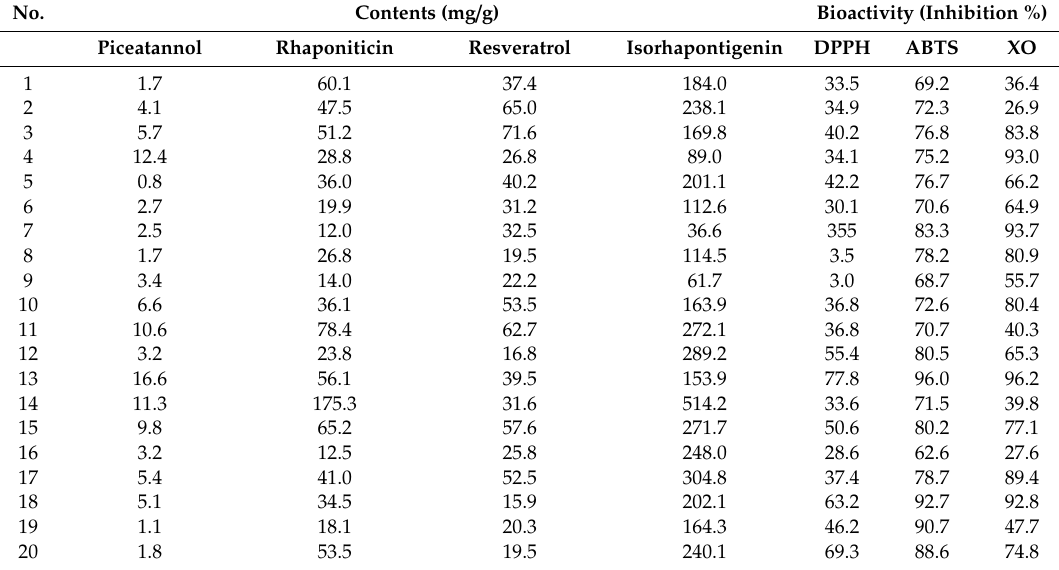
Table 3. The contents of four inhibitors, radical scavenging activities and XO inhibition of twenty Gnetum parvifolium samples. The concentration of each extract was unified at 2.0 mg / mL. No.